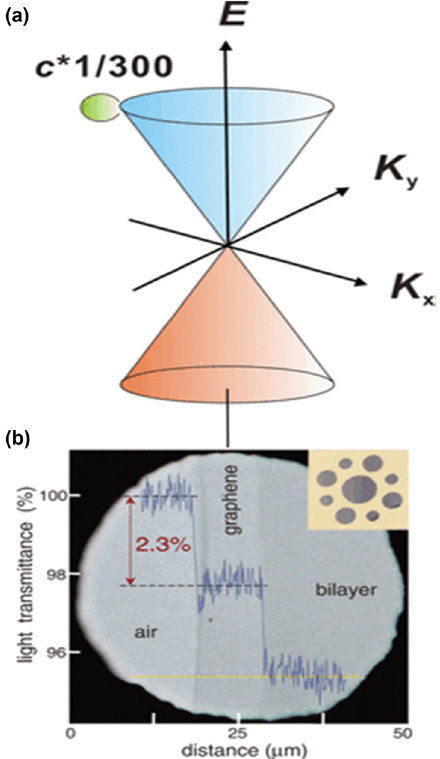
Figure 3: ( a,b ) Electronic and optical properties of graphene; linear energy dispersion of massless Dirac fermions ( MDFs ) in gra - phene [ 63 ] .